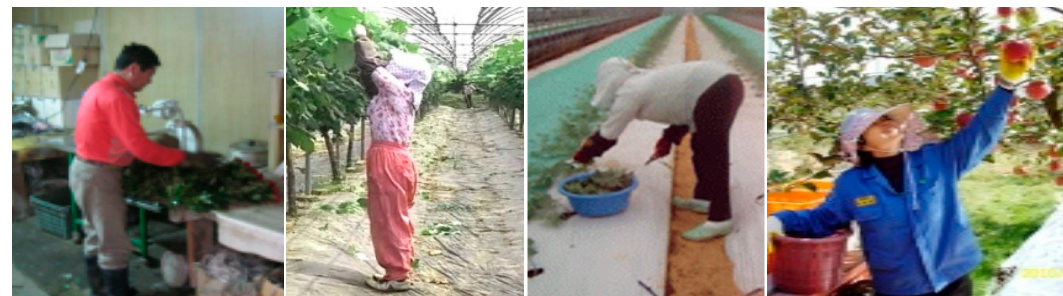
Figure 1. Examples of selected working postures. Table 1. 10 selected crops based on the working height.